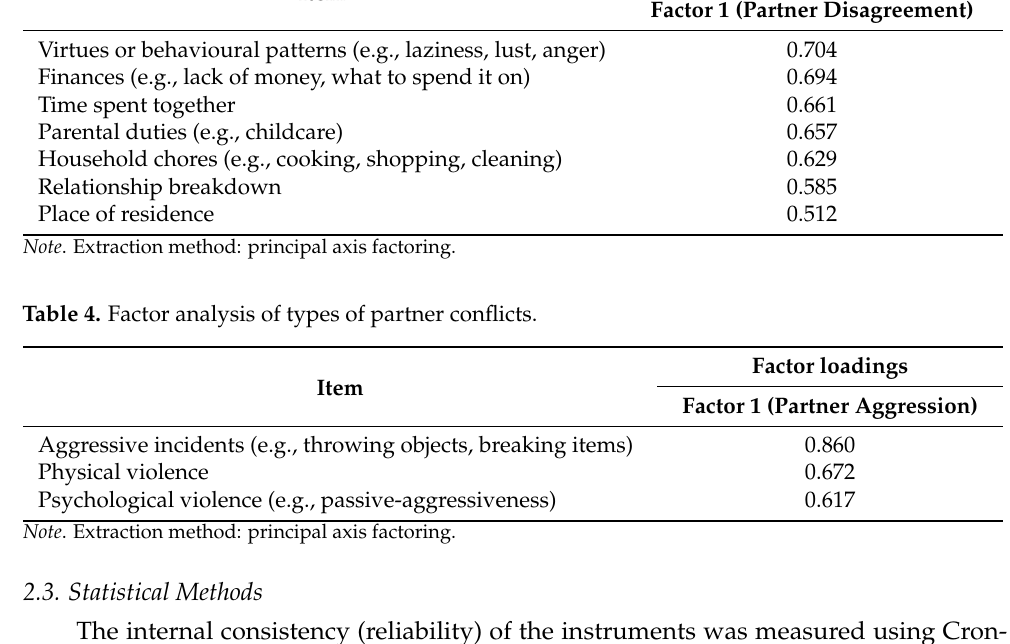
Table 3. Factor analysis of partner disagreements regarding common relationship issues. Item